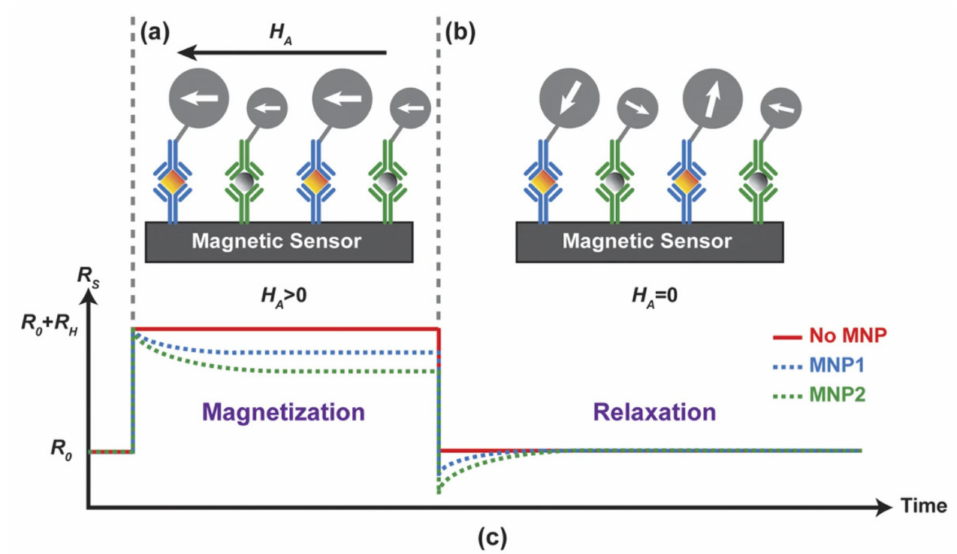
Figure 18. A schematic of an MRX sensor is shown. ( a ) In the magnetization phase, the magnetic moment of the magnetic nanoparticles is aligned to the external field. ( b ) In the relaxation phase, the mag-netic moments of the magnetic nanoparticles are randomized. ( c ) The resistance of the sensor in the magnetization and relaxation phases with and without nanoparticles are illustrated. Re-printed with permission from C. Huang et al., 2017. Scientific Reports 7, 45493 [148]. Copyright 2017